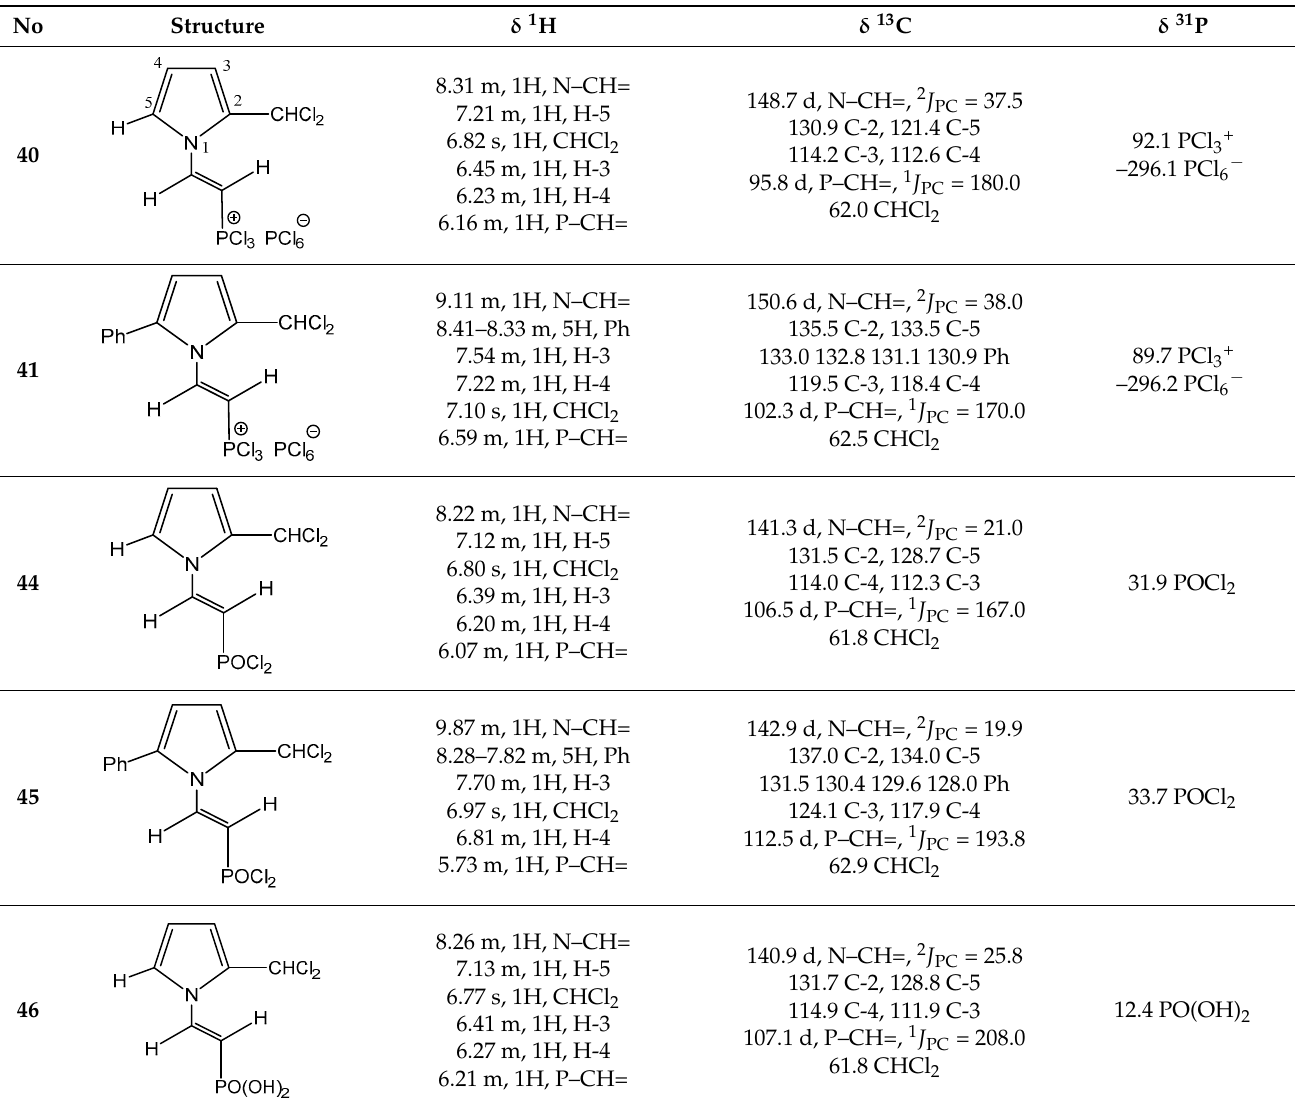
Table 15. 1 H, 13 C and 31 P NMR chemical shifts ( δ , ppm) and coupling constants ( J , Hz) of phos- phorylated pyrroles (DMSO- d 6 ).